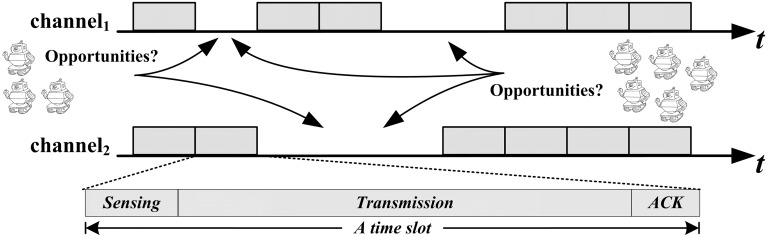
Multi-agent Multi-channel Access Opportunities.Several agents are independently seeking available communication opportunities in two channels, a suitable mechanism is required to ensure smooth communication and low conflicts.